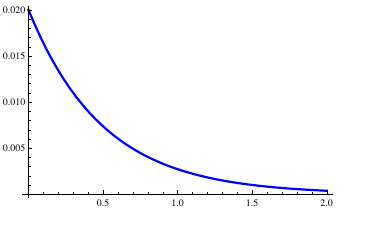
Figure 4. Synchronization is sensitive Figure 5. Synchronization is sensitive with respect to the choice of the sign of A . with respect to the choice of the sign of A . Synchronization decays for A = − 1 , We have synchronization loss for A = 1 , ω 1 = ω 2 . Graphics of the measure D ( t ) of ω 1 = ω 2 . Graphics of the measure D ( t ) of the synchronization. Initial data θ (0) = 0 . 03 , the synchronization. Initial data θ (0) = 0 . 03 , φ (0) = 0 . 02. φ (0) = 0 .